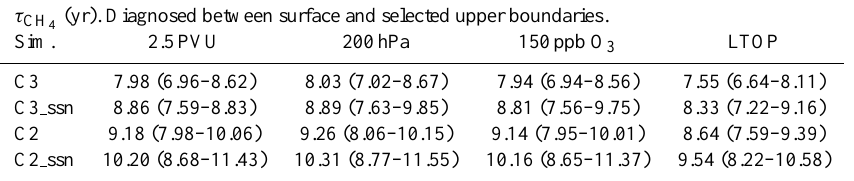
Table 4. Annual average lifetimes of CH 4 ( τ CH ), diagnosed as the total CH 4 burden (surface to model top) divided by the loss of CH 4 4 within the four diagnosed domains: below the model PVU-based tropopause height, below 200hPa surface, below the modelled 150ppbO 3 surface, and the whole model domain (up to top level LTOP). All numbers are for the year 2005, and the ranges of monthly means are given in